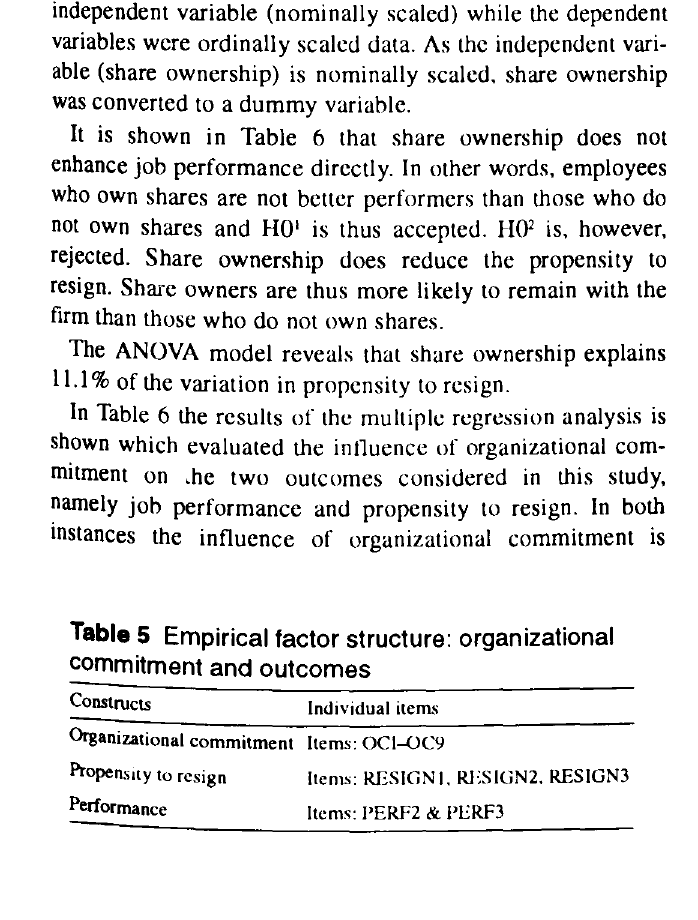
Table 5 Empirical factor structure: organizational